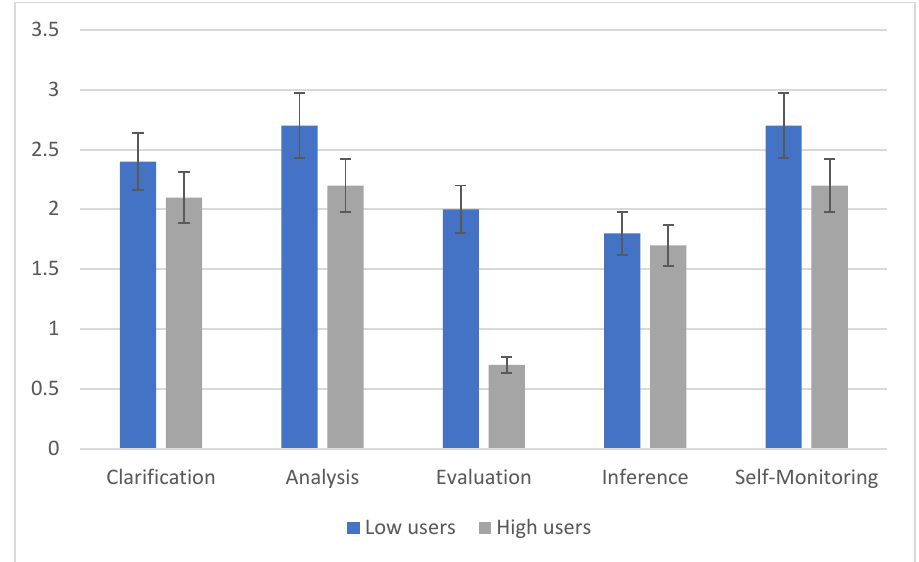
Figure 1. Means scores related to the phases of critical thinking of the social problem.